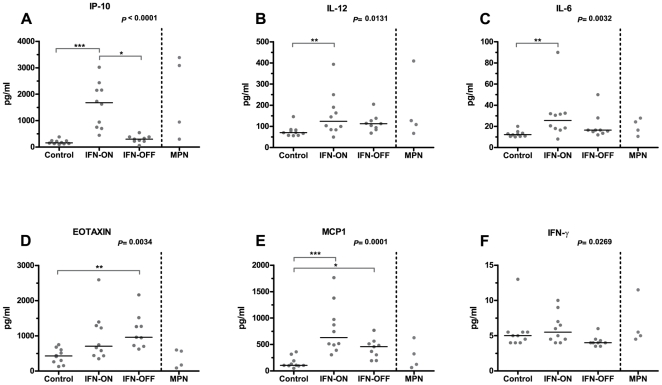
Plasma IP-10, IL-6, IL-12, eotaxin, MCP-1, and IFN-γ cytokine levels.Plasma levels of 25 cytokines were measured with a multiplex bead-based cytokine assay (Luminex®) from healthy controls (n = 10), IFN-α-treated CML patients (IFN-ON, n = 10), and CML patients who had discontinued IFN-α therapy (IFN-OFF, n = 9). Statistical significance of differences in continuous variables was assessed by a non-parametric analysis of variance using the Kruskal-Wallis test (P-values reported in figures) and in case of a significant main effect, pairwise comparisons of patient groups were calculated using Dunn's multiple comparison test (statistically significant differences between groups are marked with asterisks and line). The figures also include results from four patients with myeloproliferative neoplasm (MPN), but they were not included in the statistical analysis.